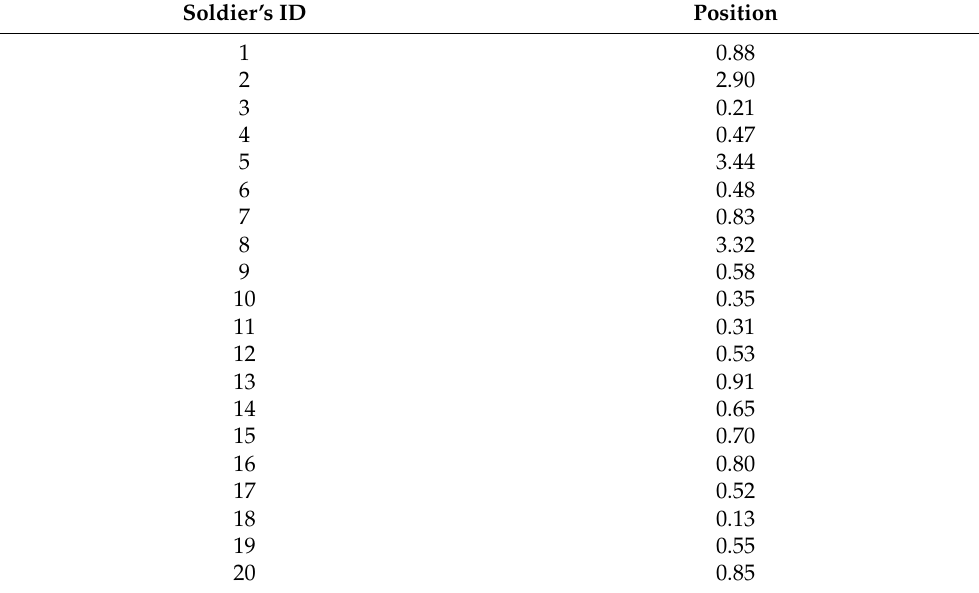
Table A2. Artificial scout position